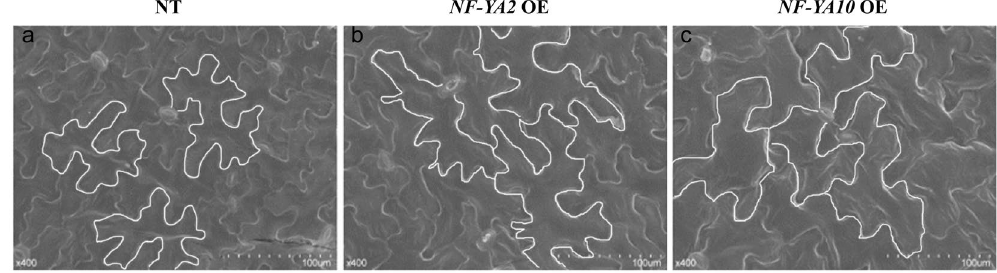
Figure 2. SE micrograph of a leaf of 8-week-old plant. ( a ) Negative transgenic plant; ( b ) NF-YA2 OE plant; ( c ) NF-YA10 OE plant.